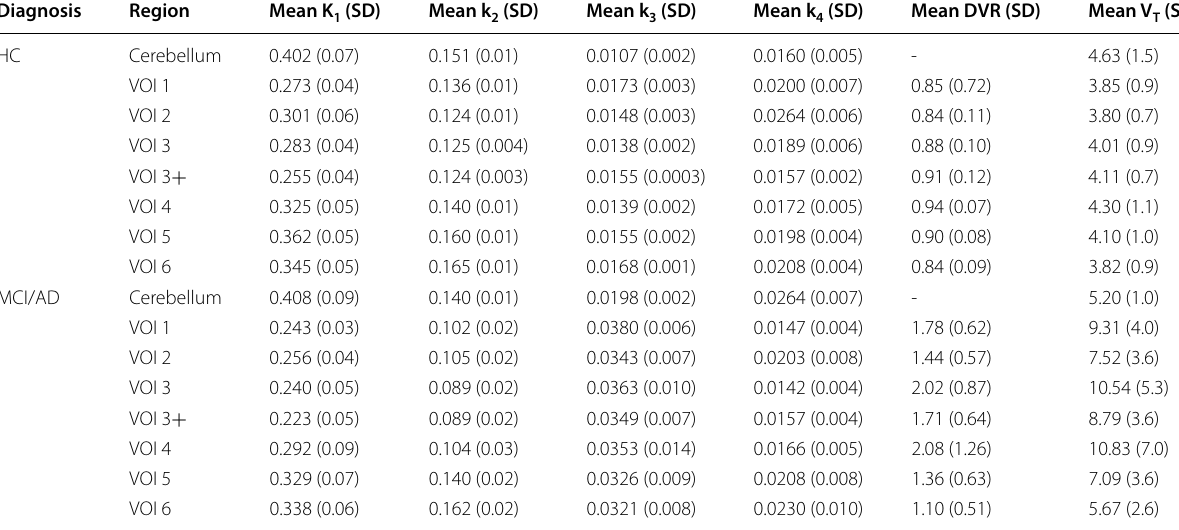
Table 2 Average kinetic parameters from the two-tissue compartment model